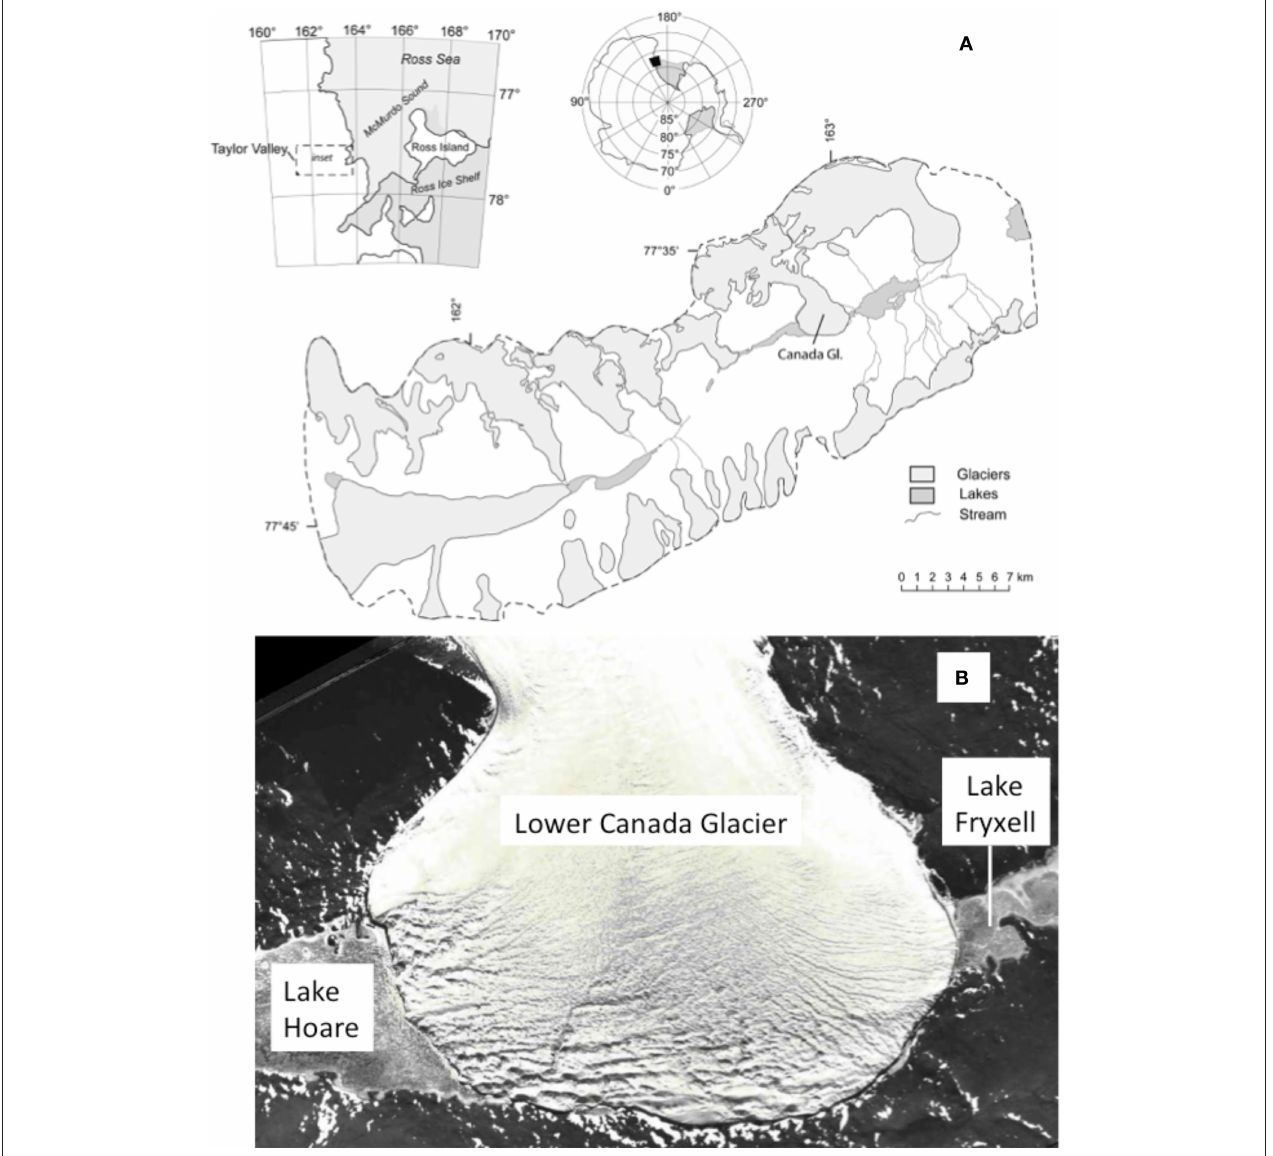
FIGURE 1 | (A) Map of Taylor Valley Antarctica with Canada Glacier shown (reprinted from Lyons et al., 1998 with permission of the copyright holder AGU). (B) The lower Canada Glacier where cryoconite and supraglacial stream sampling occurred. Note the lower glacier feeds Andersen Creek and Canada Stream which drains into Lake Hoare and Lake Fryxell,